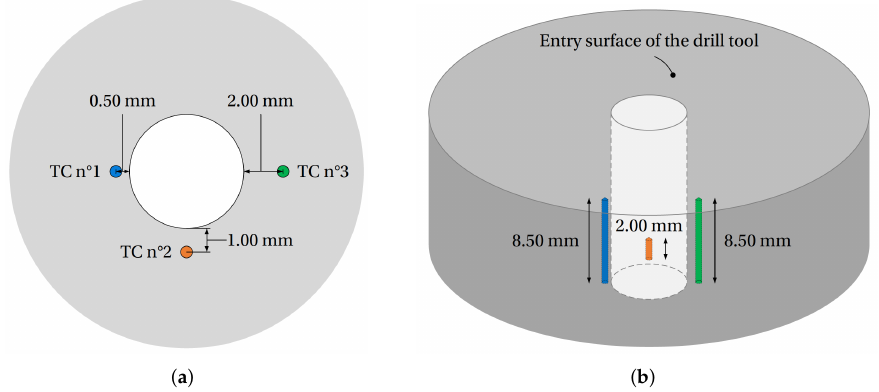
Figure 4. Position of the thermocouples: ( a ) radial positions; and ( b ) depth